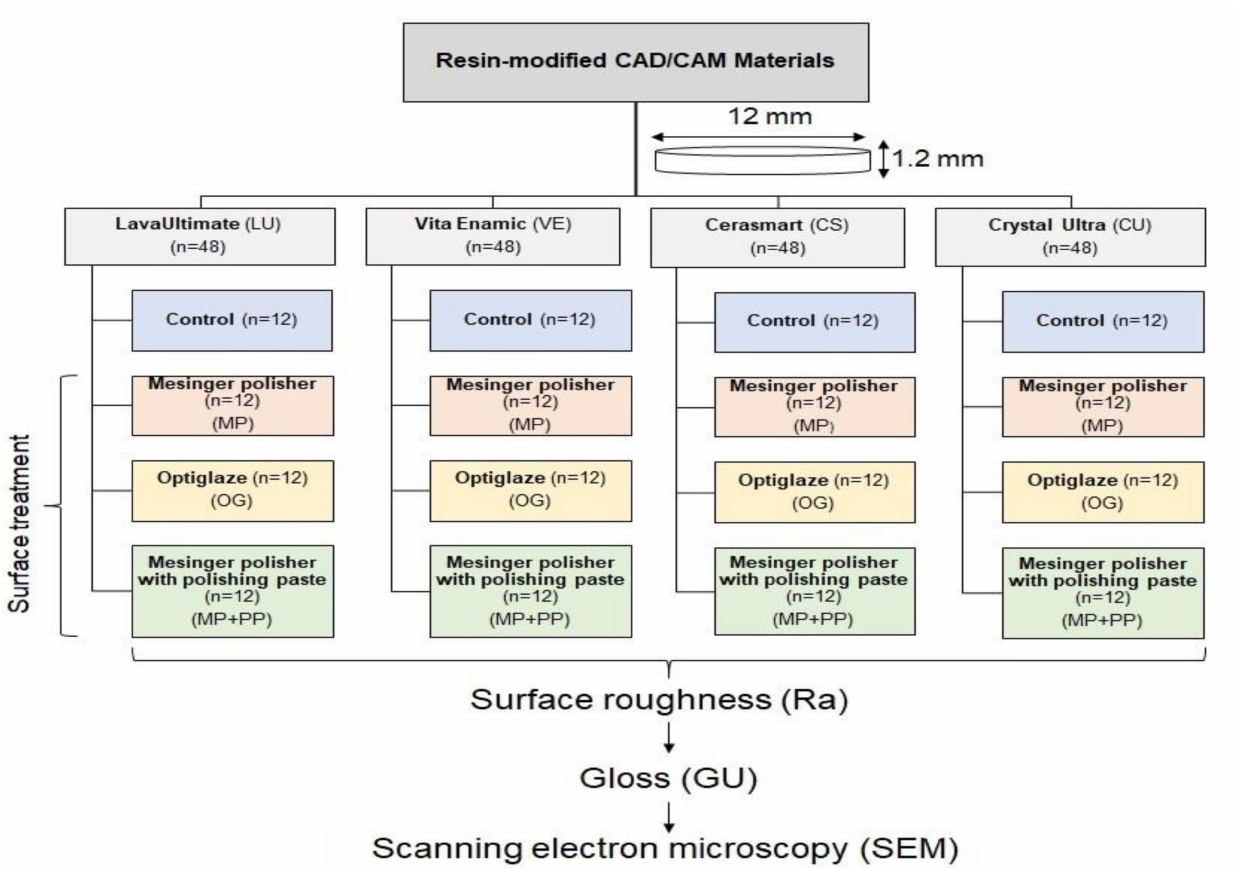
Figure 1. Flowchart for the specimen distribution and study